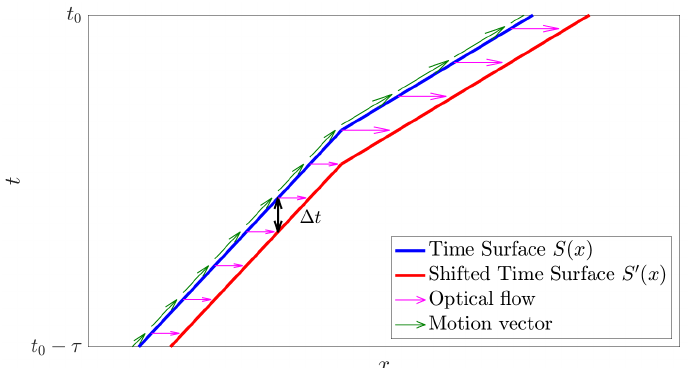
Figure 3. A one-dimensional time surface when the velocity changes over a time period of τ . Blue and red plots indicate the time surface and the shifted time surface, respectively. The green and magenta arrows indicate the motion vector in x − t space and the optical flow, respectively. The assumption of constant speed is only necessary for the very short interval ∆ t to calculate the optical